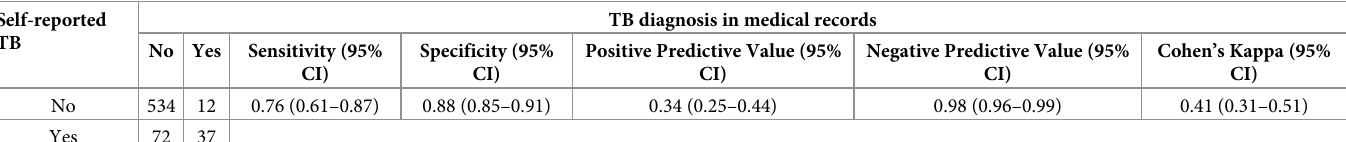
Table 4. Sensitivity, specificity, positive and negative predictive values and agreement of self-reported TB compared to TB based on medical records of PLWH in Florida. Self-reported TB